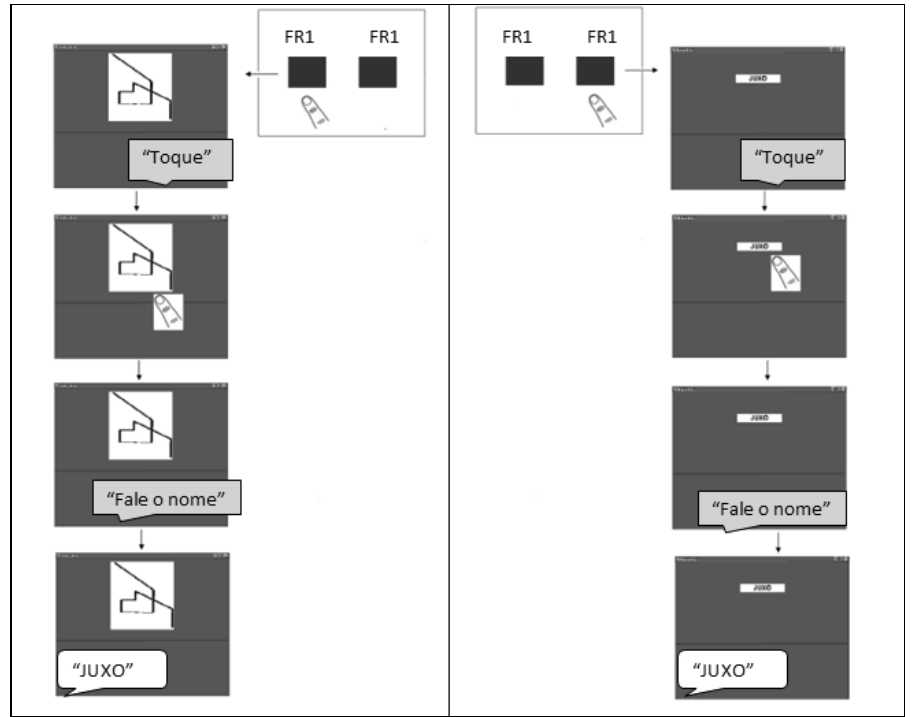
Figura 2 . Esquemas da tarefa de escolha sob esquema de reforço concorrente com